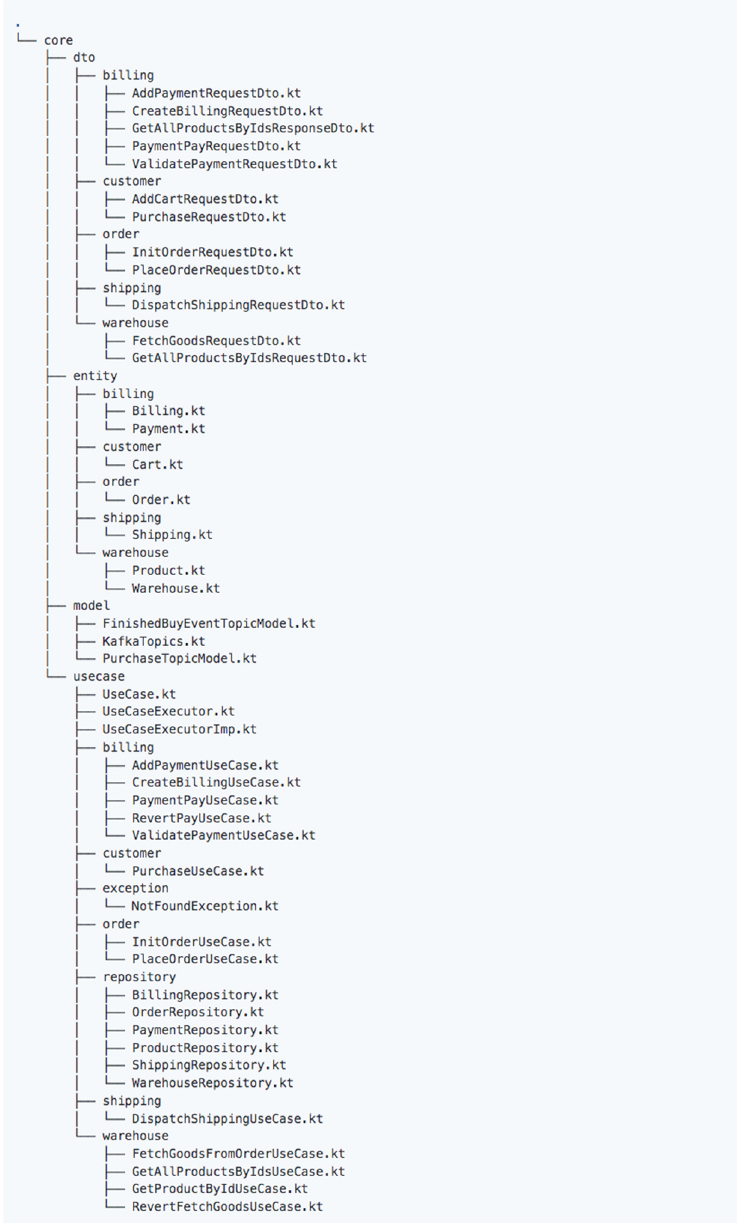
Figure 4. The tree of the implemented e-commerce system modules.